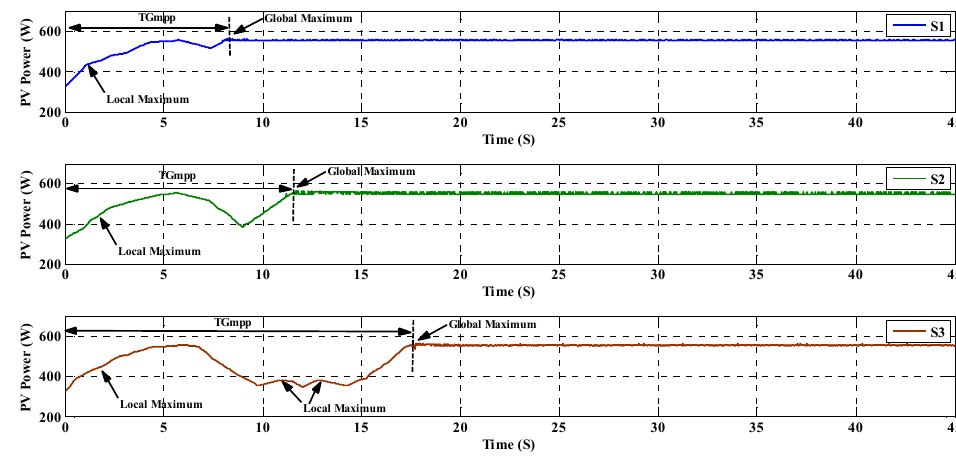
Figure 19. PV output power for the scenario in Figure 18.